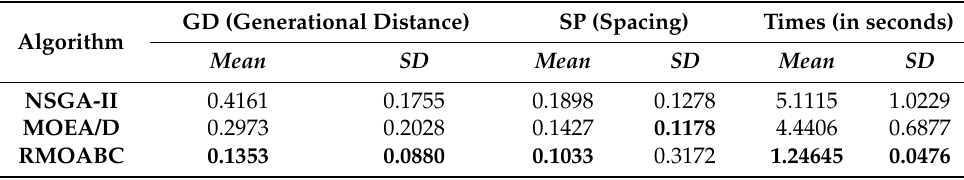
Table 7. Results of the performance metrics for UF4 function of the